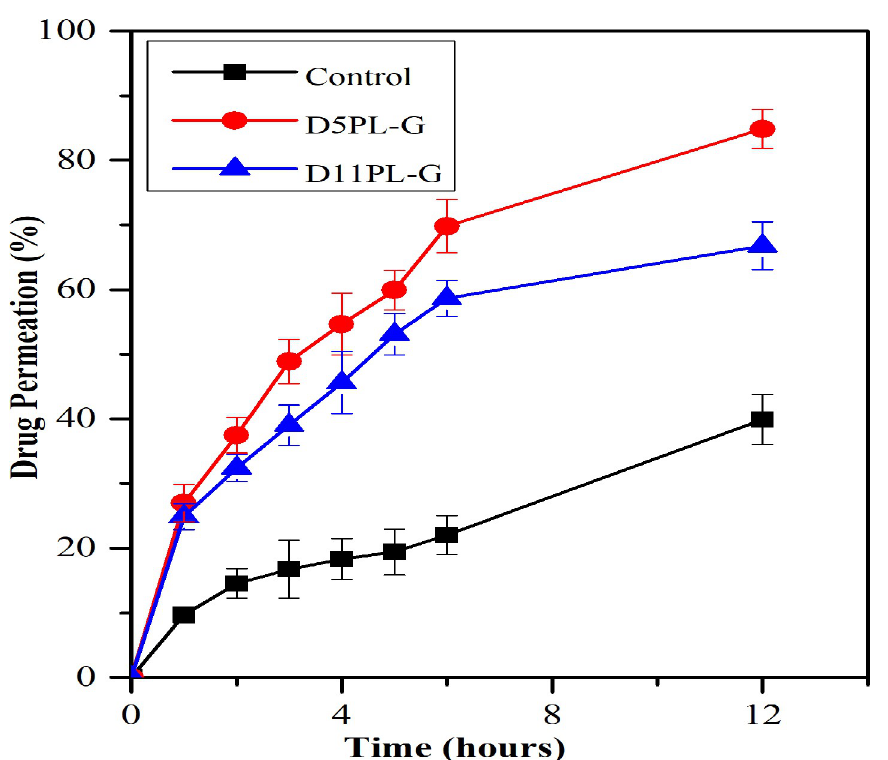
Fig 6. Ex vivo permeation analysis of control gel and liposomal gels (D5PL-G and D11PL-G).